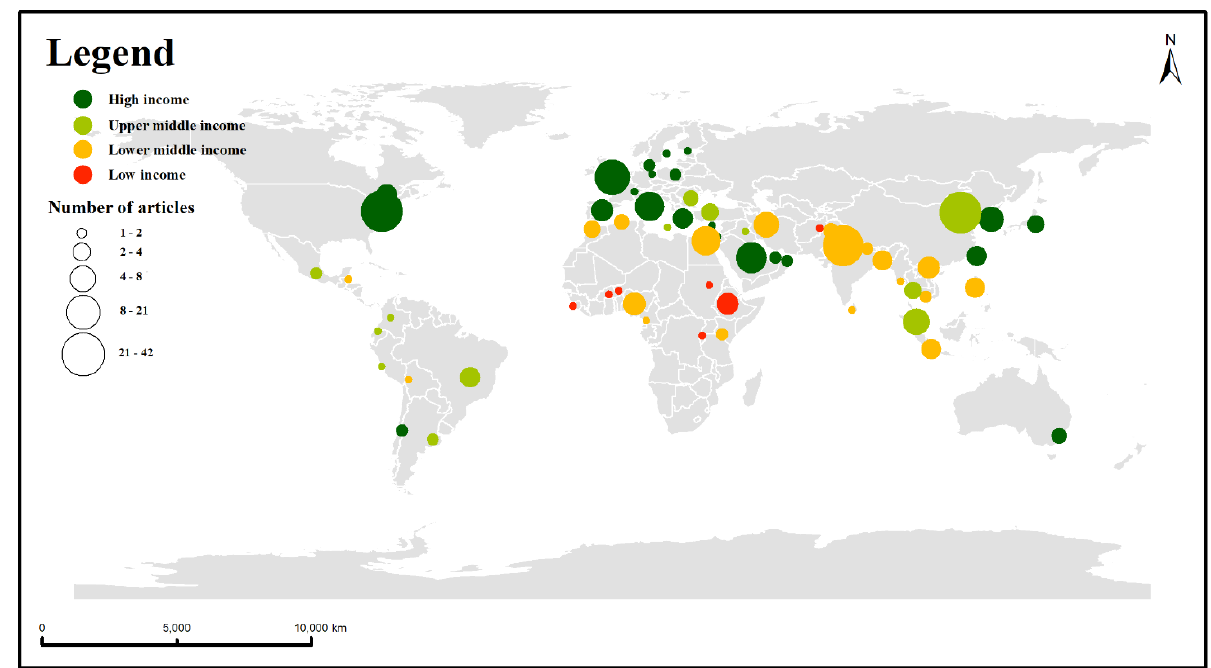
Figure 3. The number of articles and World Bank economy classification for study area coun- 202 try/territory.